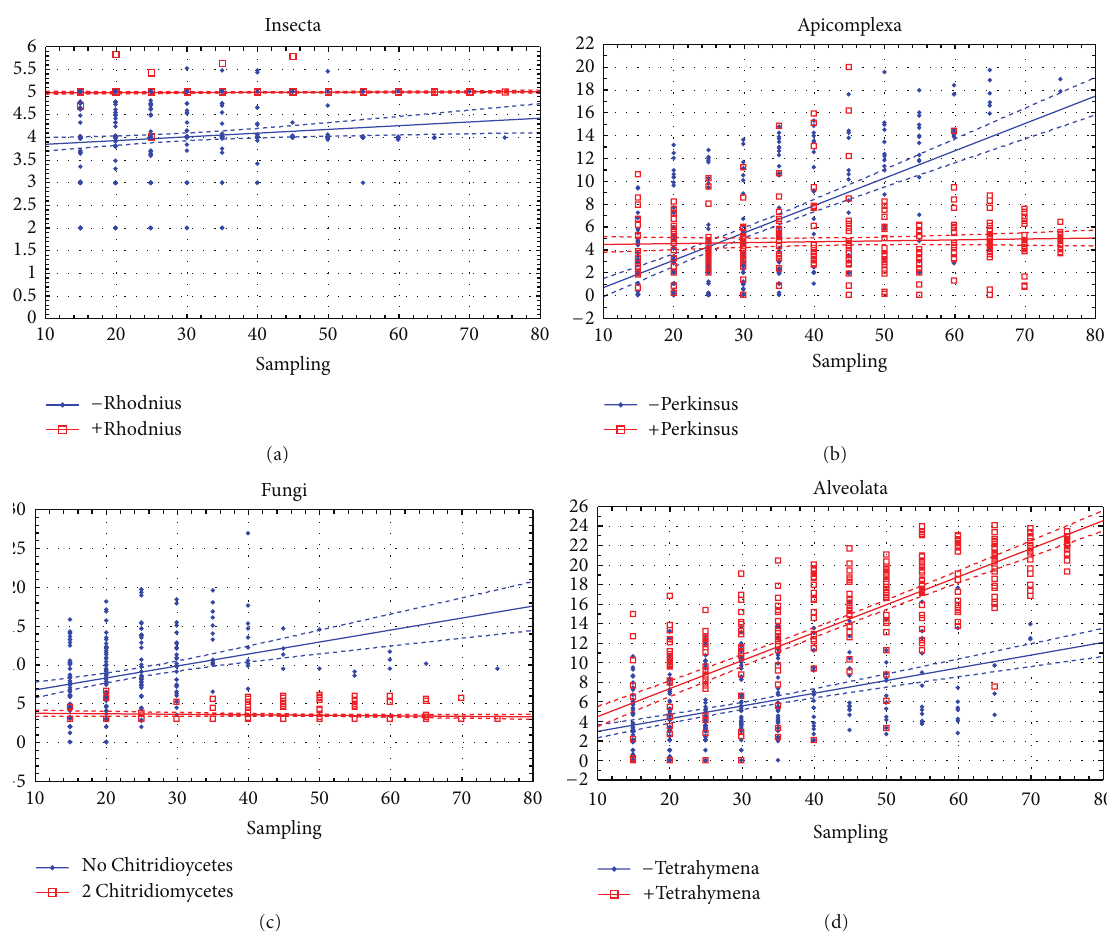
Figure 4: Effects of critical species sampling on the behavior of the Csuros algorithm. Horizontal axis: number of species in the sampling. Vertical axis: inferred intron density at the node